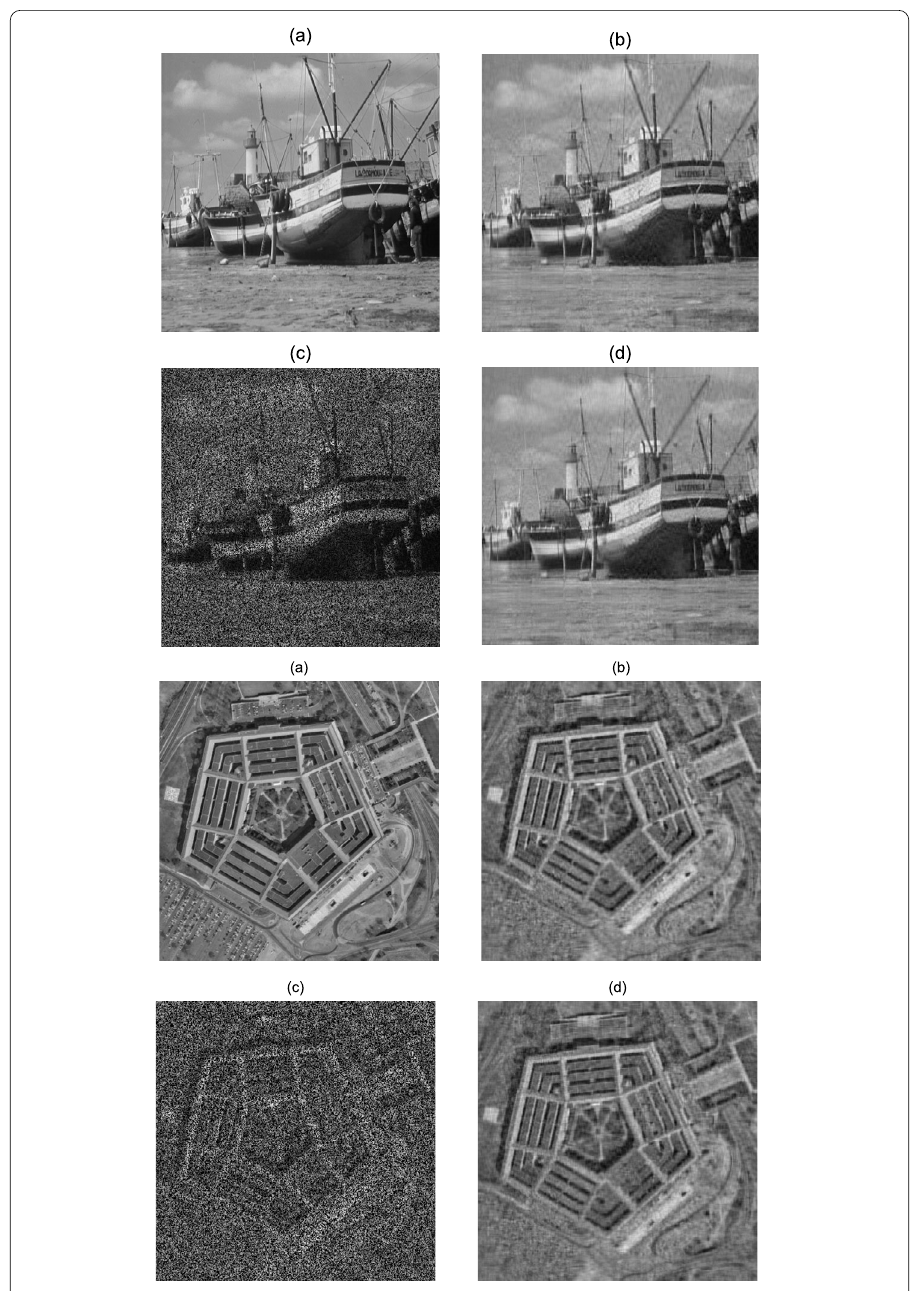
Figure 4 ( a ) Original image; ( b ) low rank image with r = 40; ( c ) the corrupted image with sr = 50%; ( d ) the recovered image by